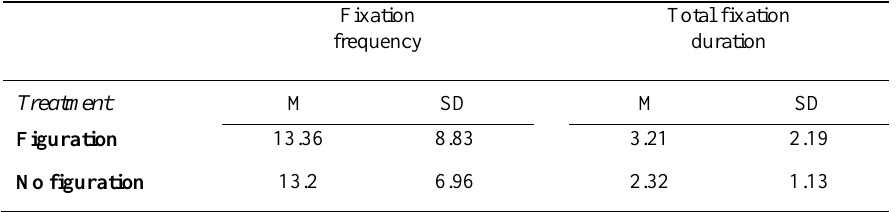
Table 3. Means (M) and Standard Deviation (SD) of Attention Measures for Ad Copy Typeface ROI: